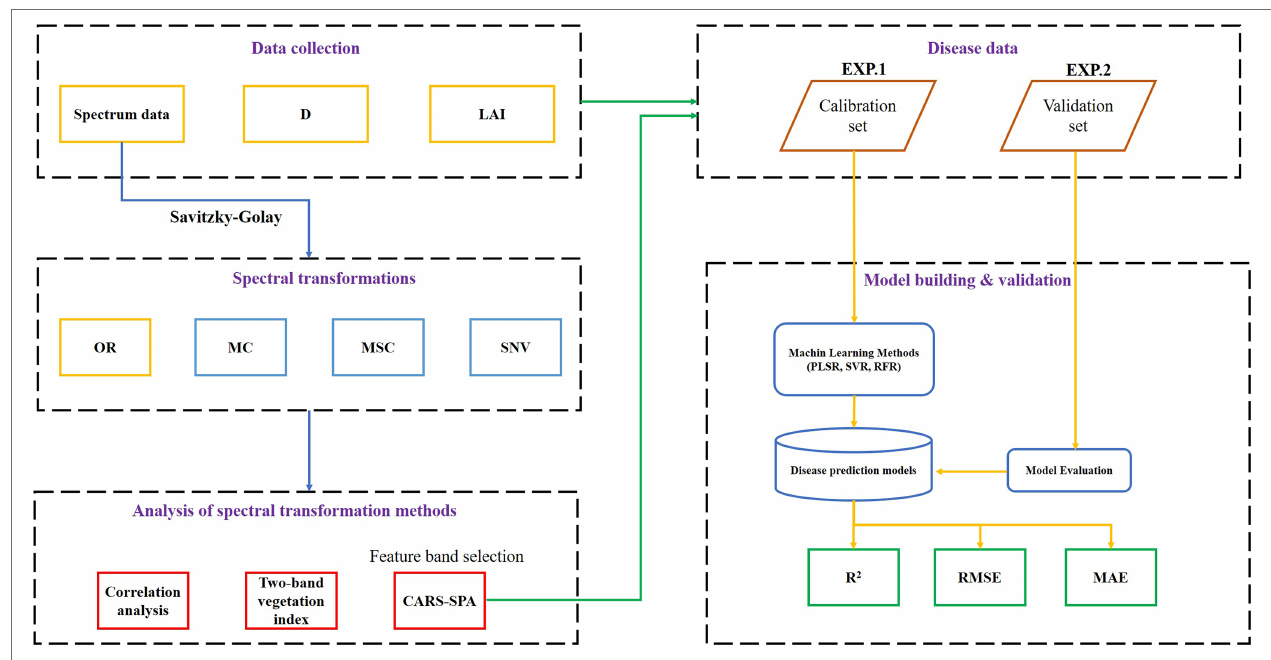
FIGURE 1 | The overall technical workflow of the